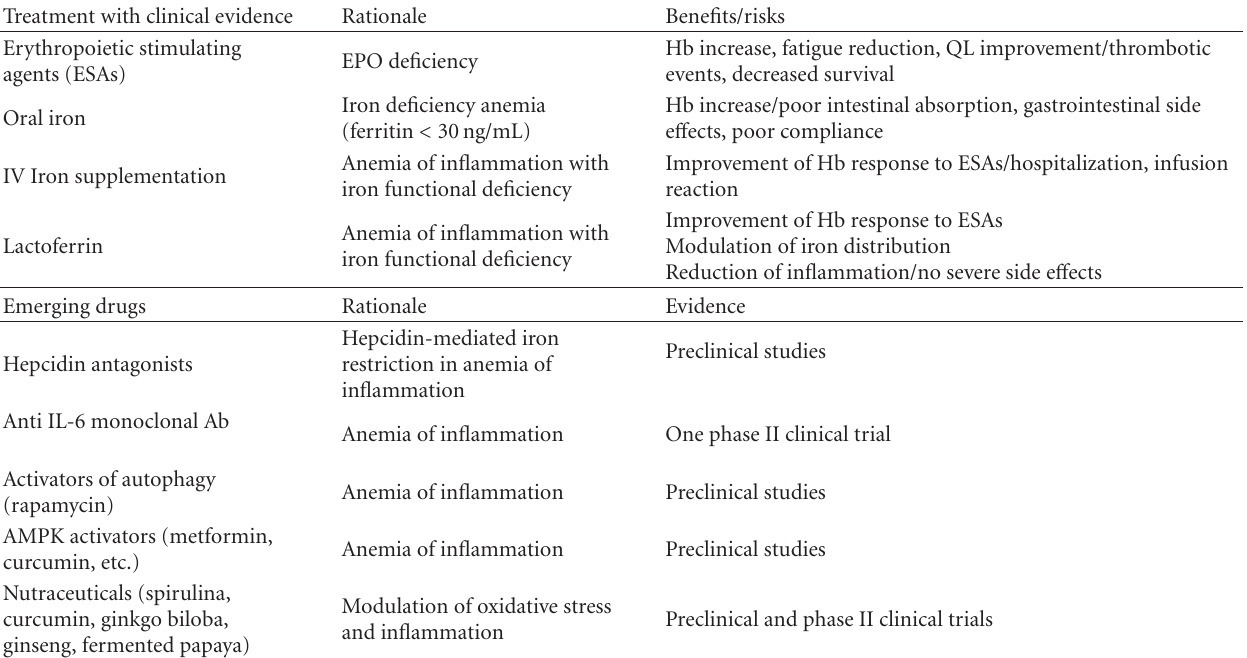
Table 1: Di ff erent options of treatment of anemia of inflammation in the